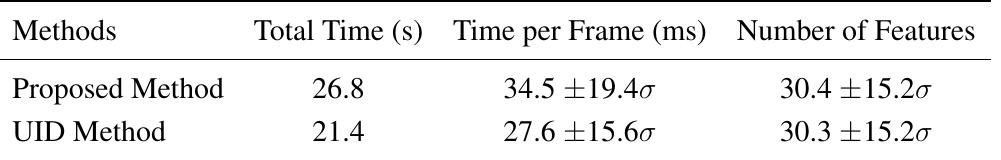
Table 2. Experiment (b): execution time and number of features into the system